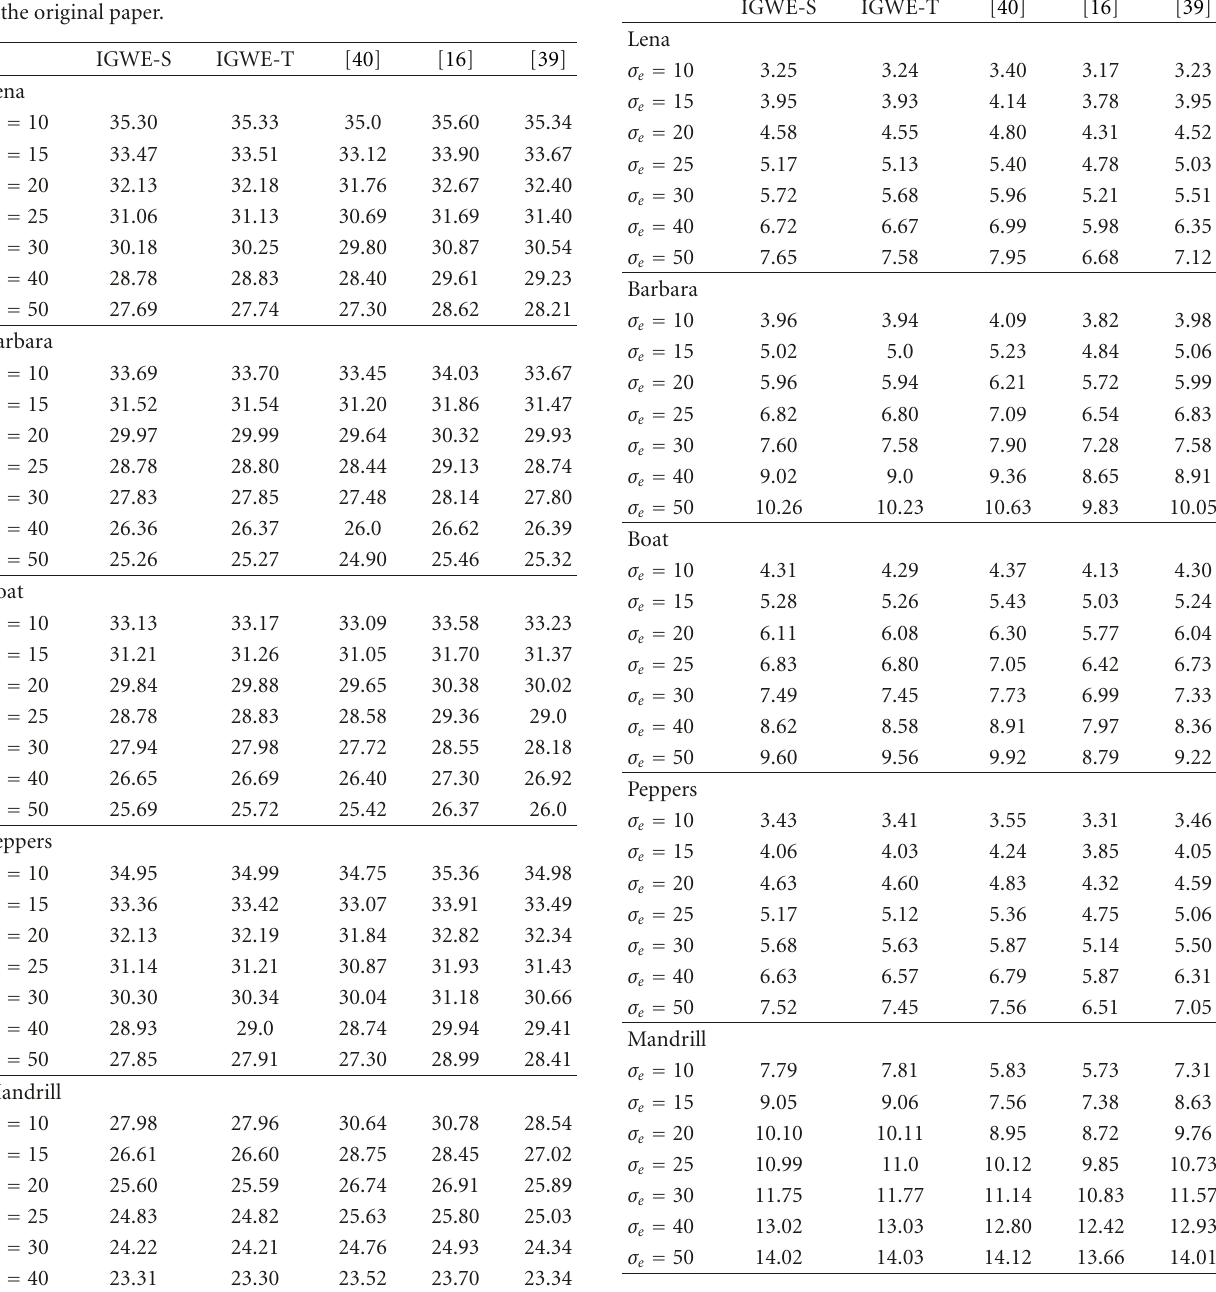
Table 5: A comparison of denoising results based on the mean absolute error. Five test images are used under di ff erent noise